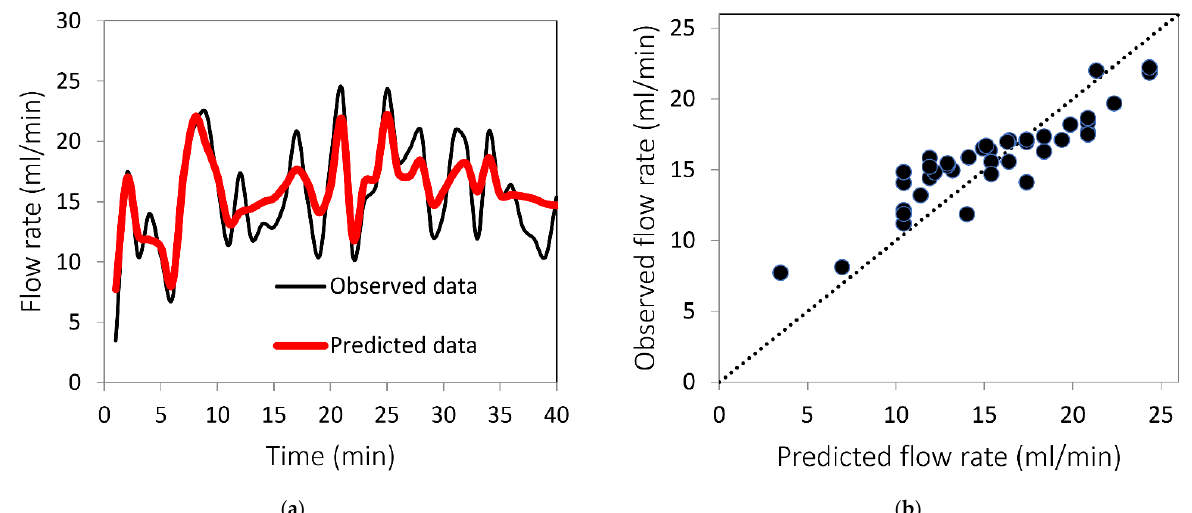
Figure 12. Prediction of flow rate time series: ( a ) comparison between observed and predicted flow rate over time; ( b ) scatter plot of predicted flow rate versus observed flow rate.